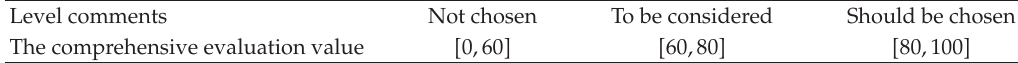
Table 1: Comparison between the results of evaluation and the level of